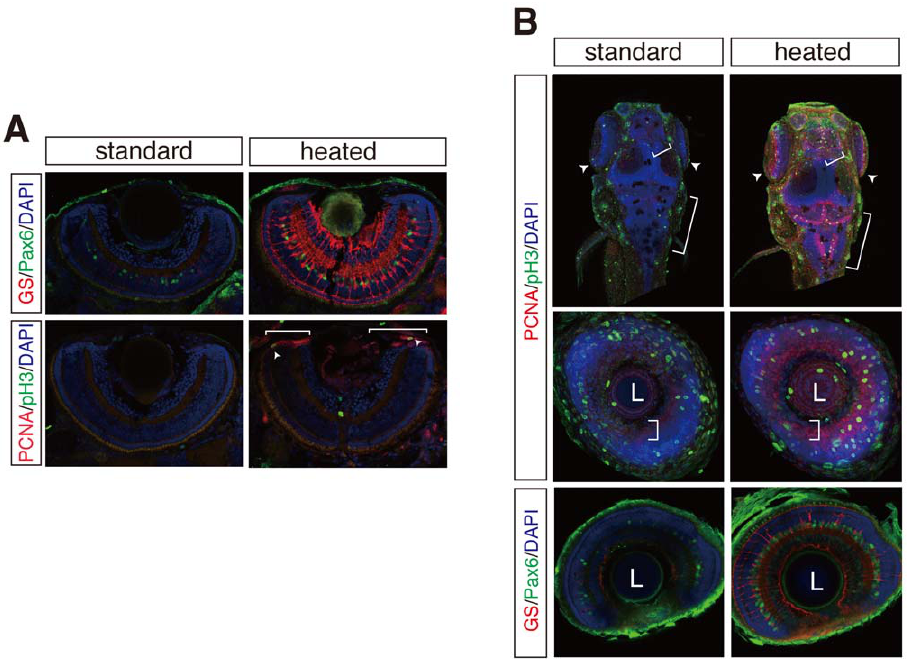
Figure 3. Multiple fluorescent immunostaining of cryosections and whole mount embryos by the heating method. ( A ) GS/Pax6 (top panels) and PCNA/phospho-histone H3 (pH 3) (bottom panels) immunostainings on cryosections of zebrafish retinae. GS and Pax6 immunostainings detect amacrine and Mueller glia cells. pH 3-positive mitotic cells (arrowheads) co-localize to PCNA-positive retinal progenitor cell region (brackets) in the ciliary marginal zone (CMZ). ( B ) Whole mount fluorescent immunostainings as in A with or without the heating method. Maximum projection of dorsal view of whole mount zebrafish (top panels). Coronal optical sections of zebrafish retina (middle and bottom panels). Brackets and arrowheads indicate proliferative zones of hindbrain, optic tectum, telencephalon, and CMZ. L; lens. Nuclei were counterstained with DAPI (blue).